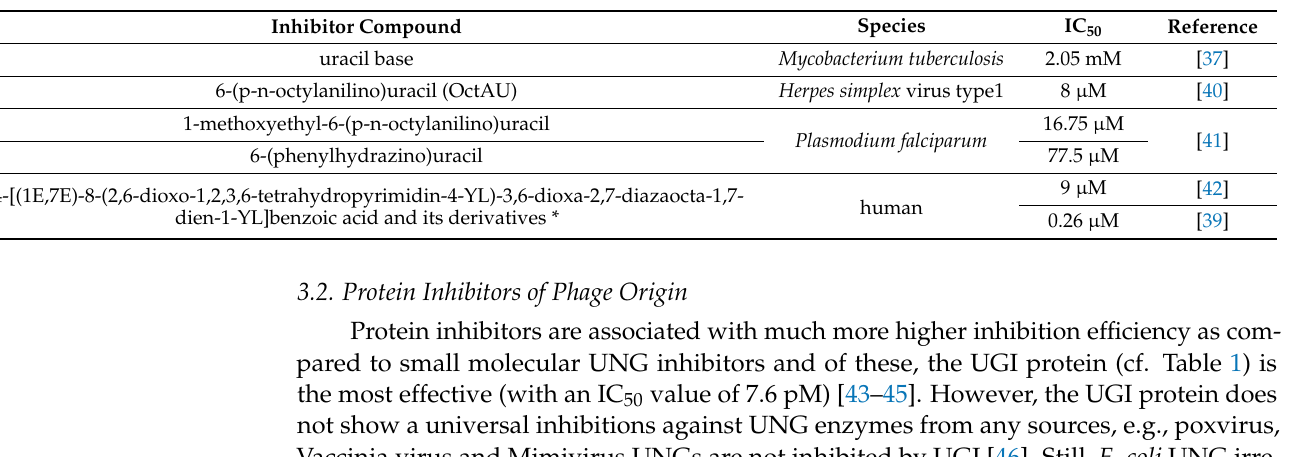
Table 2. Properties of some specific DNA glycosylase inhibitors. *: In a follow-up study, several derivatives of this compound were also investigated and showed submicromolar IC 50 values